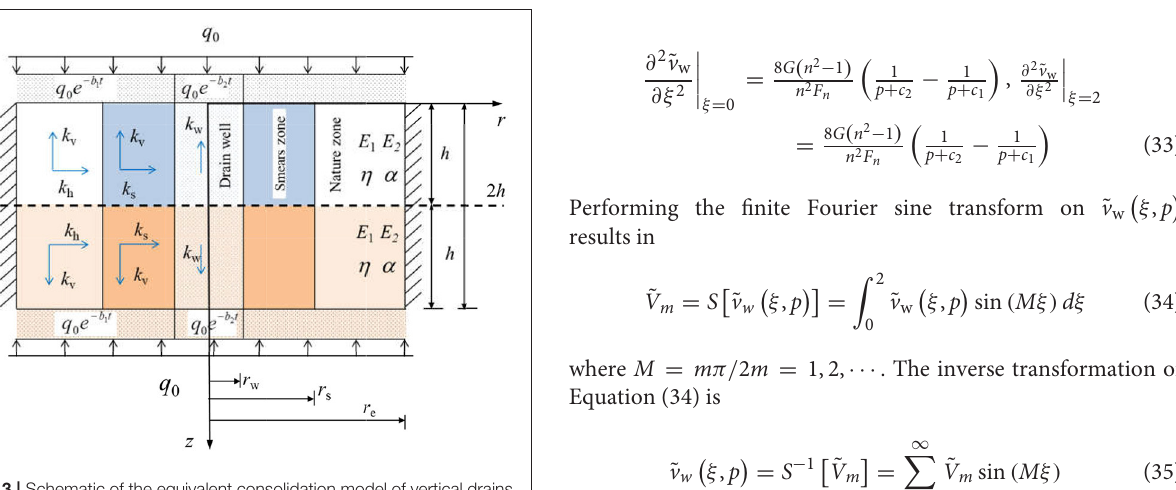
FIGURE 3 | Schematic of the equivalent consolidation model of vertical